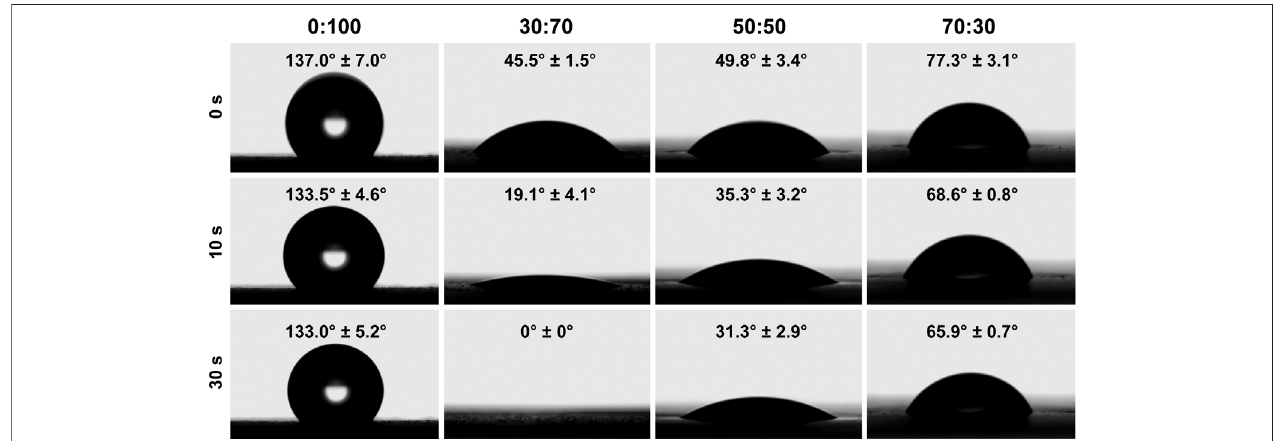
FIGURE 2 | Water contact angles of different nano fi brous membranes.